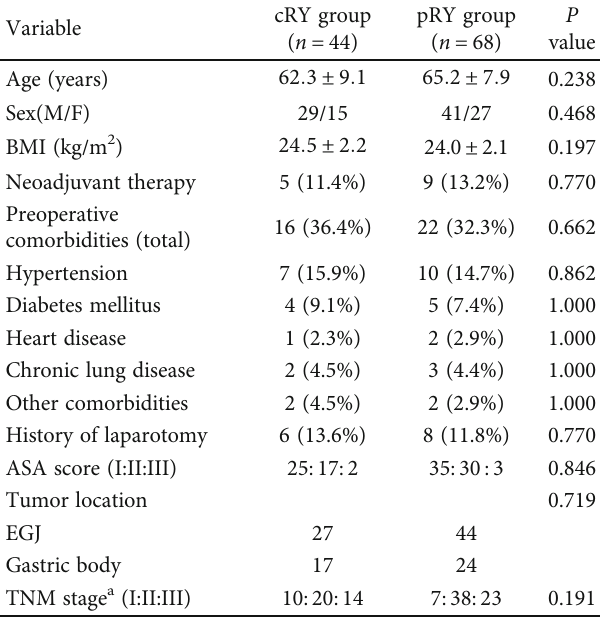
Table 1: Clinicopathological information of the patients in the cRY group and the pRY